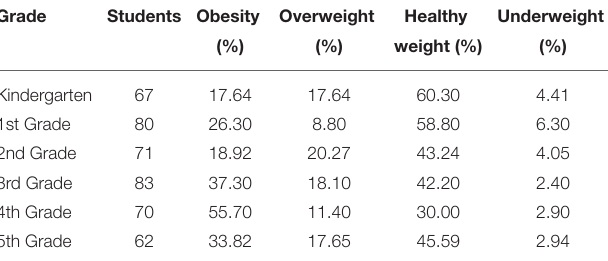
TABLE 1B | Prevalence of each weight category in kindergarten through fifth